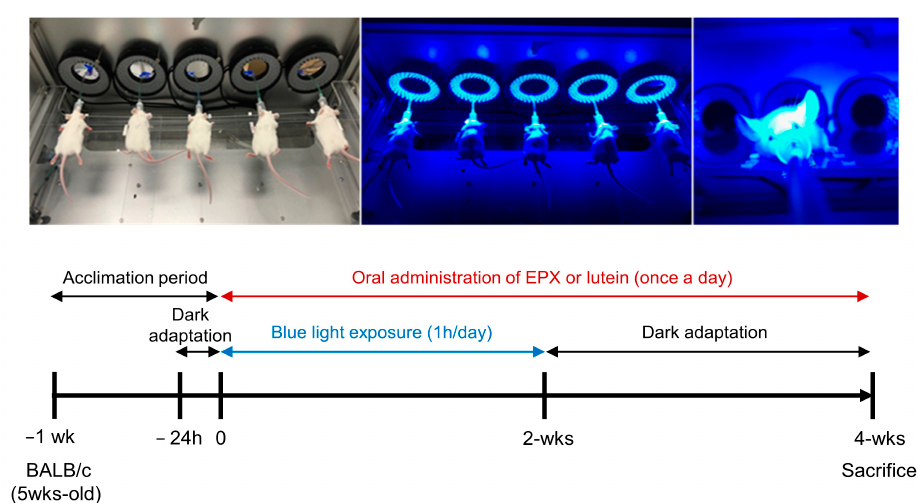
Figure 1. Schematic representation of the in vivo experimental design. Blue light exposure was performed 14 times (1 h/day) at 10,000 lux using a blue light irradiator after anesthetizing mice with isoflurane.